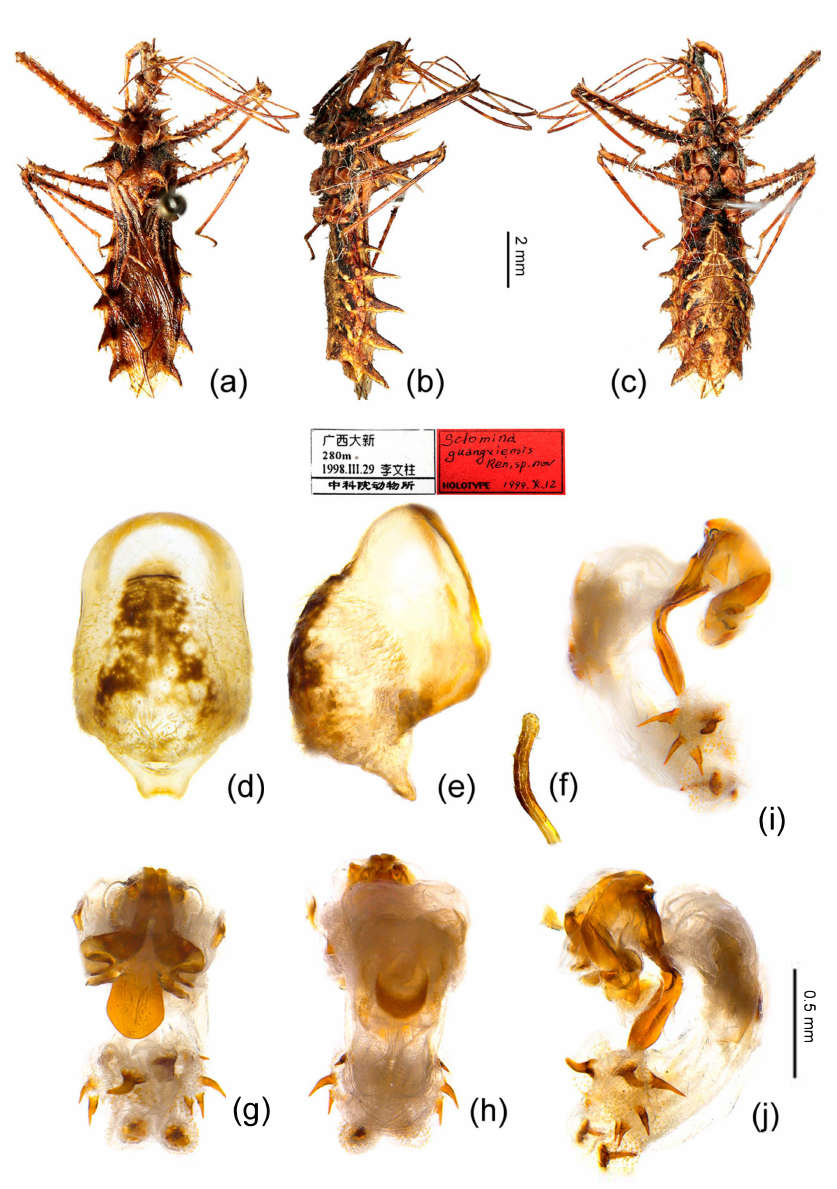
Figure 8. Sclomina guangxiensis Ren, 2001. ( a – c ) male, Holotype, habitus; ( d – j ) male, GXLZ, male external genitalia. ( d , e ) pygophore; ( f ) paramere; ( g – j ) phallus. ( a , g ) dorsal view; ( b , e , i , j ) lateral view; ( c , d , h ) ventral view. Scale bar of ( a – c ) = 2 mm, ( d – j ) = 0.5 mm. Sclomina guangxiensis Ren, 2001: 1. Diagnosis: This species S. guangxiensis is similar to S. erinacea , but in the former the body color is dark reddish-brown, the posterior pronotal lobe is with black markings,